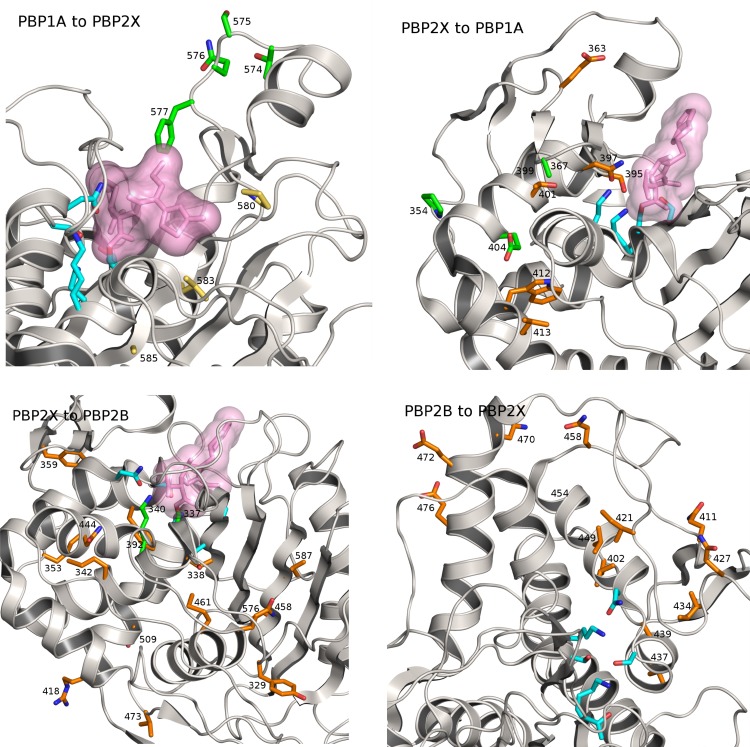
Structural models of pbp1a, pbp2x, pbp2b with the 100 strongest couplings listed in S3 Table indicated.The figures show the transpeptidase domains of each PBP with catalytic/active site residues shown in cyan and coupled positions as sticks with other colors. Active site bound antibiotic/inhibitor is rendered as a space-filling volume when present in the crystal structure. Panels A-D depict: pbp1a with couplings to pbp2x, green colored residues are coupled with green residues in panel B; orange colored residues in B are coupled with both green and yellow residues in A (A), pbp2x with couplings to pbp1a (B), pbp2x with couplings to pbp2b in orange (C), pbp2b with couplings to pbp2x in orange (D).